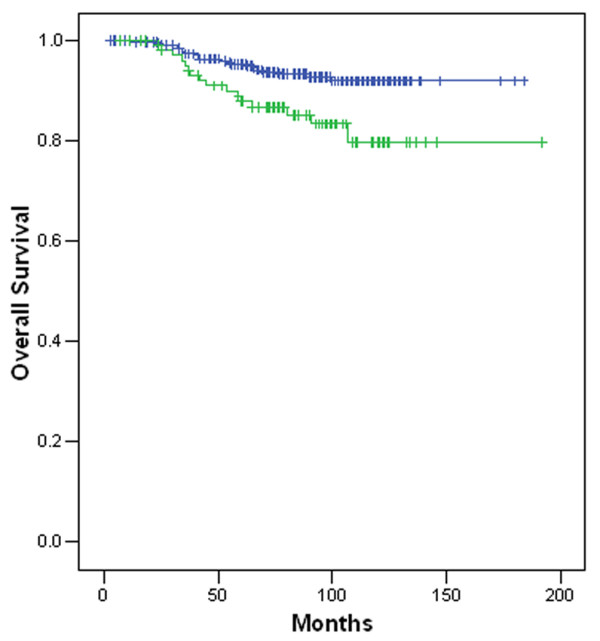
Percentage of Lewisy/b positive cells and overall survival in node-negative breast cancer patients (n = 430). Kaplan-Meier analysis showed that patients with a low percentage of Lewisy/b positive cells (blue curve: <25% positive cells, n = 315) have significantly longer survival times than patients with >25% positive tumour cells (green curve: n = 115, p = 0.006).